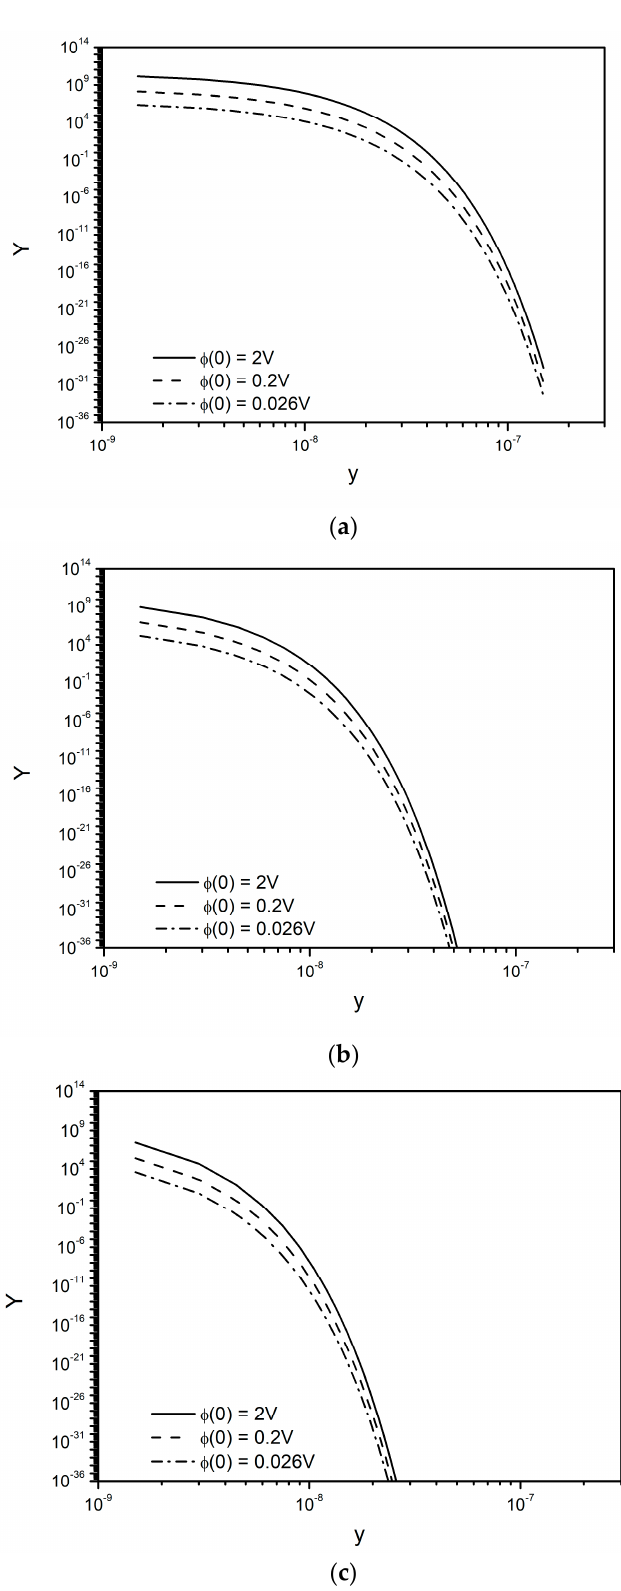
Figure 6. Effect of the nonlinearity on W at 𝜑(cid:4666)0(cid:4667) (cid:3404) 0.026 (cid:4666)𝐚(cid:4667), 0.2 (cid:4666)𝐛(cid:4667) and 2 (cid:4666)𝐜(cid:4667) along 𝑦 for various 𝐶 (cid:3014) .